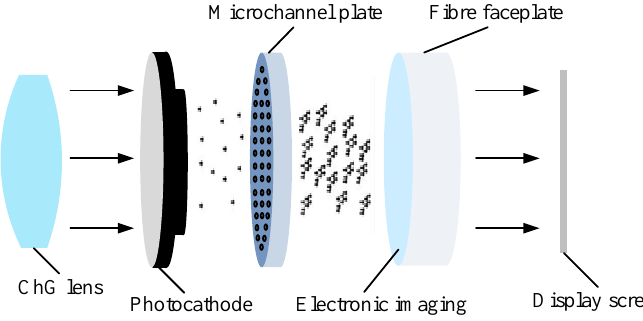
Figure 1. Schematic diagram of night vision system.